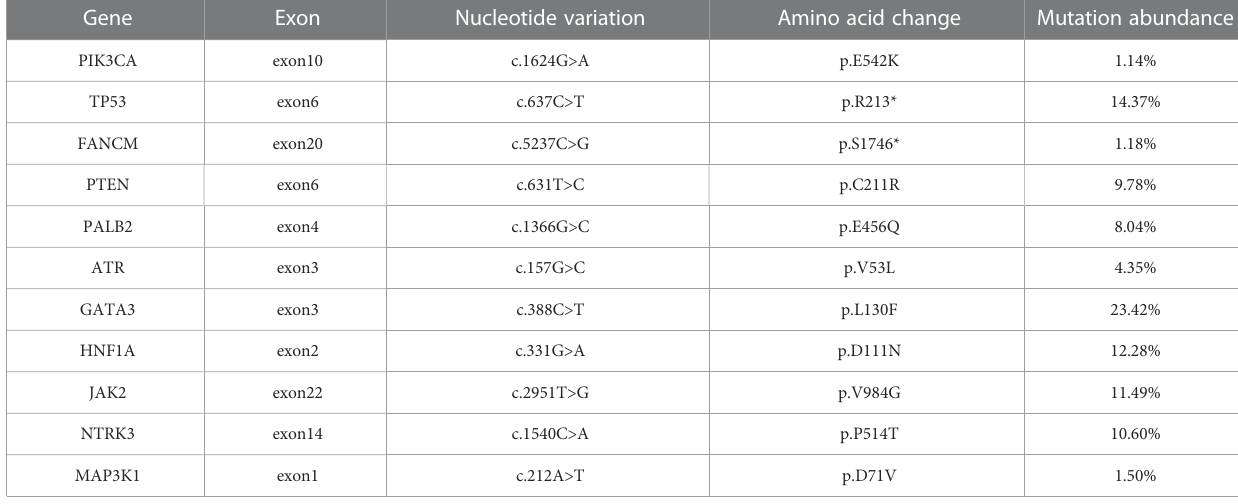
TABLE 1 List of somatic mutations.